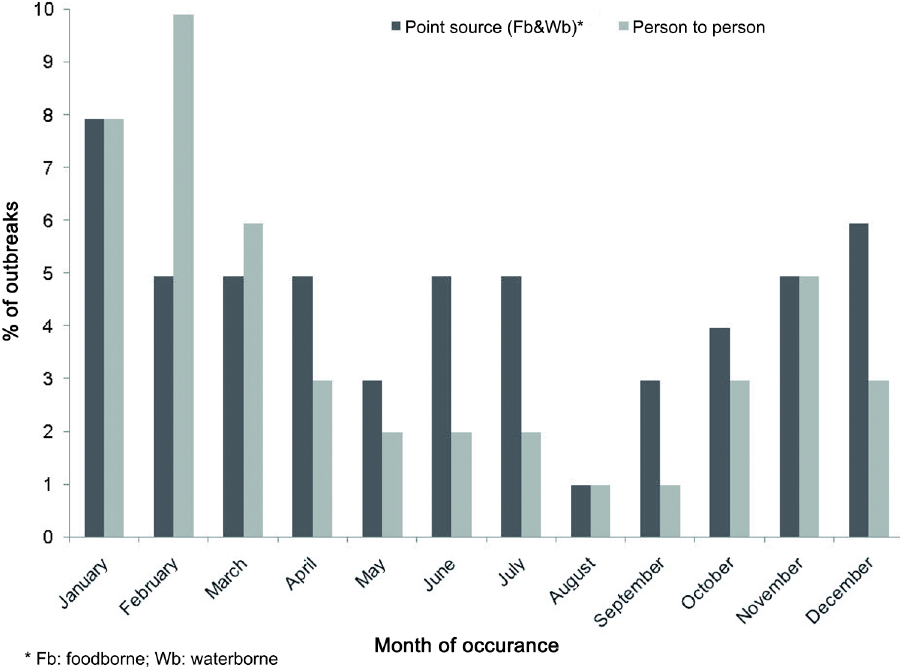
Fig 1. Distribution of acute gastroenteritis outbreaks by month of occurrence and transmission mode. Catalonia 2010 and 2011. * Cold months (November to April) significantly higher incidence than warm months (May to October) for both transmission modes (Table